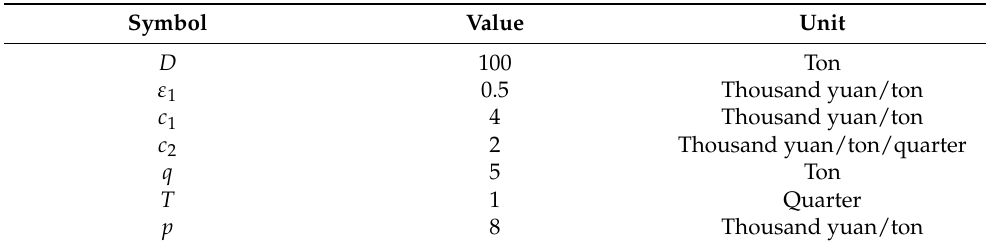
Figure 4. Effect of demand forecast errors on optimal sales incentives, production quantity, and expected profits. Table 5. The parametric values of the sequential optimization decision model when the prediction errors of refined oil demand are